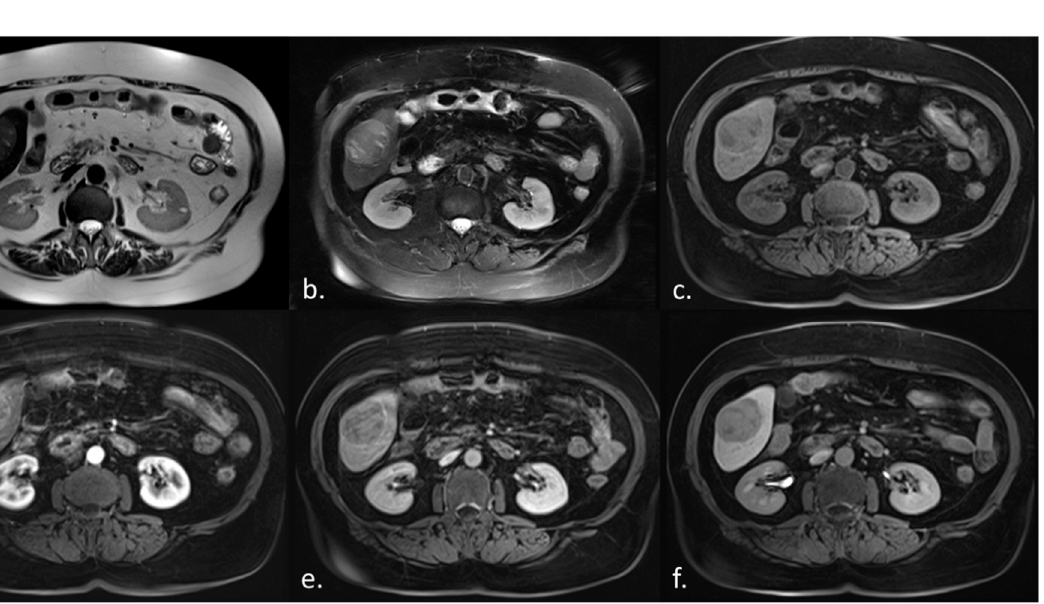
Figure 1. HCC size measurements vary between different MRI pulse sequences. Figure 1 shows an HCC in the right liver lobe measuring 4.9 cm in the T2w half-Fourier-acquired single-shot turbo spin echo sequence ( a ), 5.2 cm in the T2w turbo spin-echo sequence ( b ), 4.9 cm in the T1w volumetric interpolated breath-hold examination sequence ( c – f ) pre-contrast ( c ), 5.3 cm in the arterial phase ( d ), 5.2 cm in the venous phase ( e ), and 4.8 cm in the hepatobiliary phase ( f ). Histopathologic assessment revealed a tumor diameter of 4.5 cm.